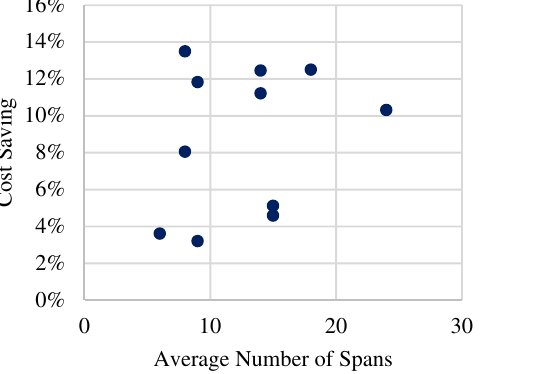
Figure 13. Sensitivity of the cost saving to the average slab aspect ratio, total floor area, and average number of